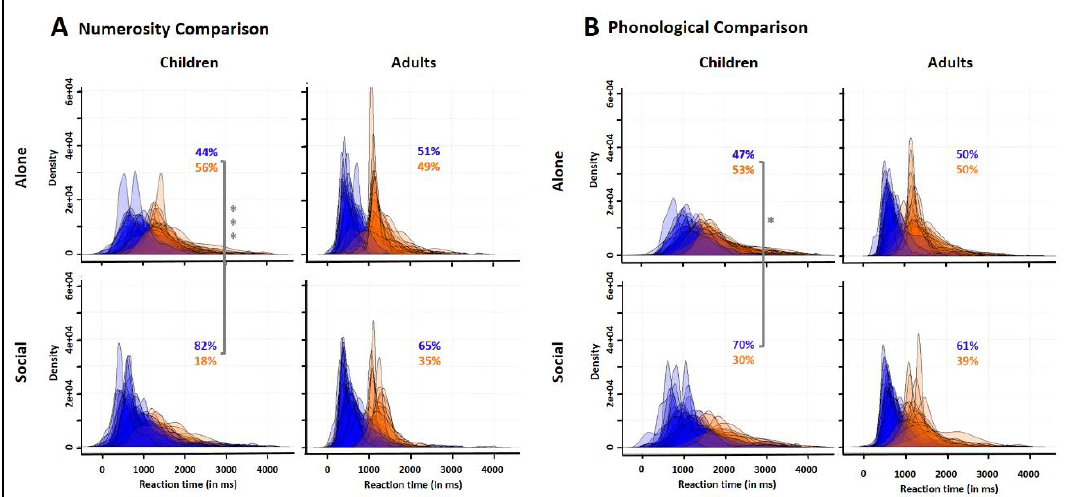
Figure 6. Superimposed individual RT distributions classifying children and adults into fast responders (with an early RT peak; blue) vs. slow responders (with a late RT peak; orange) for numerosity ( A ) and phonological ( B ) comparisons in the Social (bottom) compared to the Alone (top) condition. The proportion (in %) of both responder types are given on each graph. Peer presence increased the proportion of fast responders (blue percentages) in children more than it did in adults. Asterisks indicate differences between the Social and Alone conditions as revealed by CMH χ 2 tests: *** χ 2 (1) = 13.81, p < 0 .001, * χ 2 (1) = 4.52, p = 0.03.